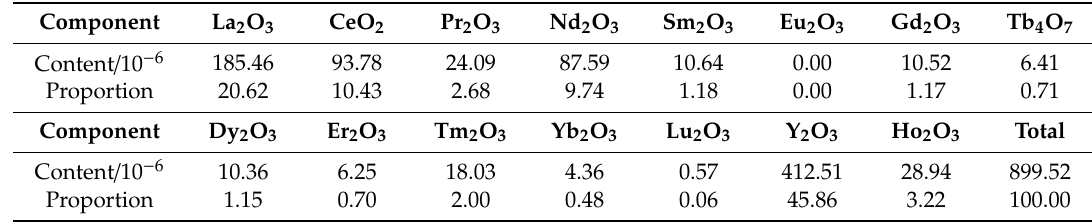
Table2. Rare-earthelement(REE)compositionsofthefeedbyinductivelycoupledplasma(ICP)analysis. Component